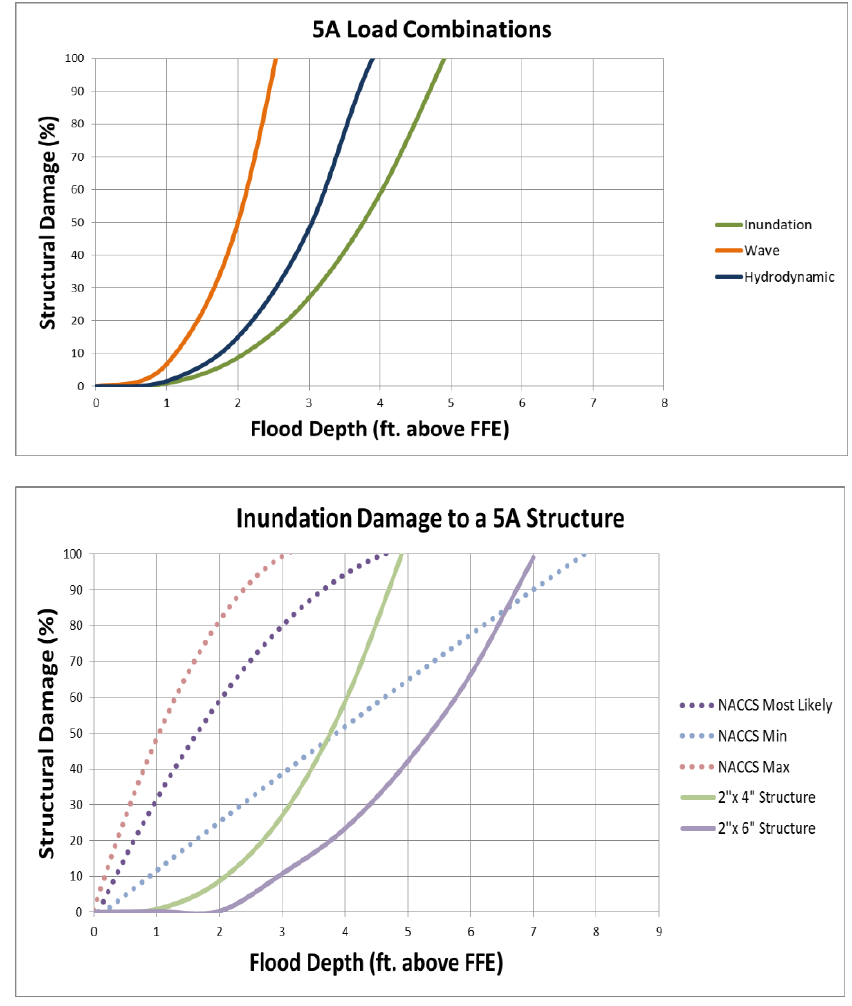
Figure 16. Structural damage based on wave, inundation, and hydrodynamic loads vs. flood depth above FFE for a single-story structure, without basement (Prototype 5A) ( upper panel), and structural damage for a 2 in × 4 in and 2 in × 6 in studded structure vs. flood depth compared to the NACCS [8] minimum, most likely, and maximum inundation damage curves ( lower panel).